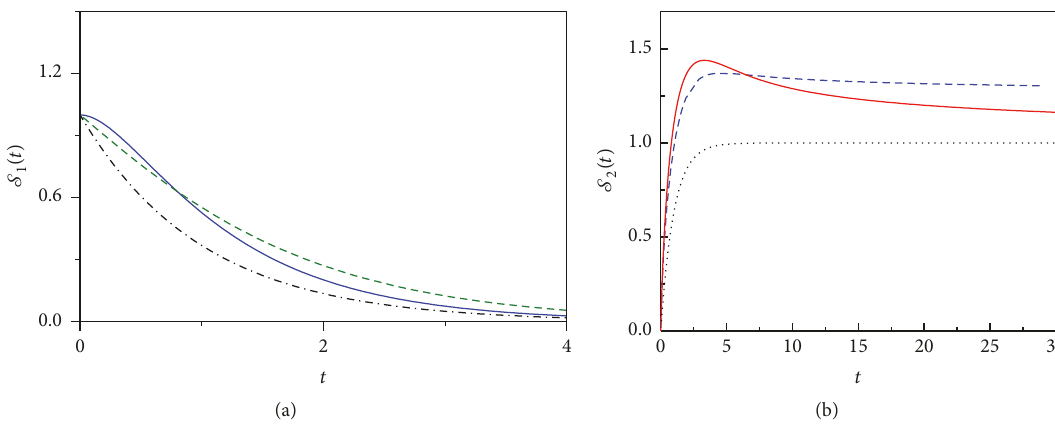
Figure 1: This figure illustrates the behavior of (14) and (15) versus 𝑡 for different scenarios. In (a) the blue (solid), black (dashed-dotted), and green (dashed) lines correspond to the cases 𝜅 = 1 with 𝜏 = 1/3 , 𝜅 = 0 with 𝜏 = 1 , and 𝜅 = 1/2 with 𝜏 = 1 . In all cases, we have used, for simplicity, 𝑘 = 1 . In (b) the blue dashed line corresponds to the cases 𝑘 = 1 , 𝜅 = 1 , 𝜏 = 1/3 , and K 1 = 2 K 2 . The black dotted line represents the cases 𝑘 = 1 , 𝜅 = 0 , 𝜏 = 1 , and K 1 = K 2 , respectively. The red solid line is the cases 𝑘 = 1 , 𝜅 = 1/2 , 𝜏 = 1 , and K 1 = K 2